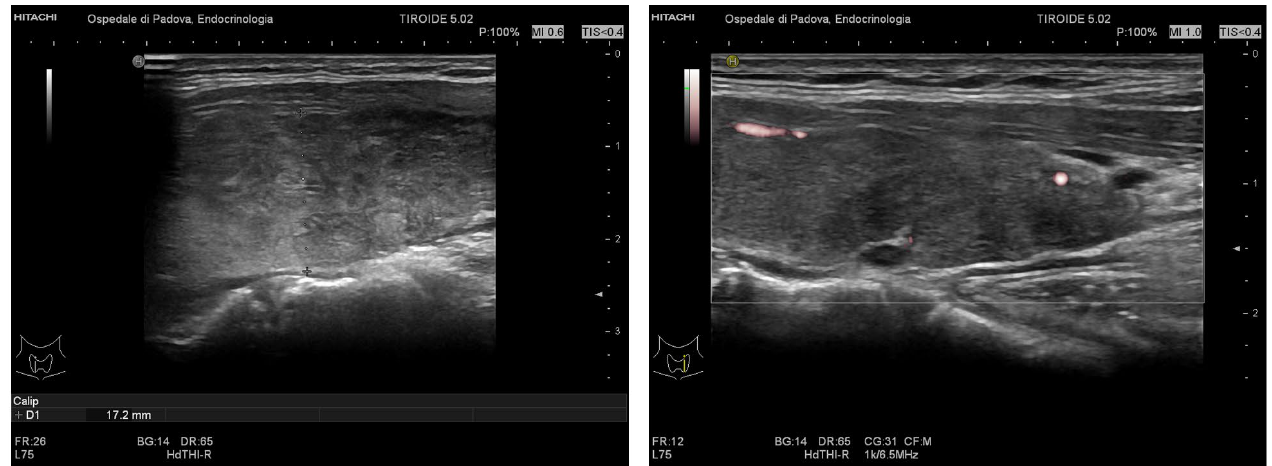
Figure 2. Thyroid ultrasound of Case 1 (right and left lobe, the latter with vascularization). The initial treatment was: methimazole 30 mg daily, prednisone 25 mg daily and propranolol 40 mg 4 times daily. Amiodarone was discontinued, and digoxin (0.25 mg daily) was considered to normalize HR.